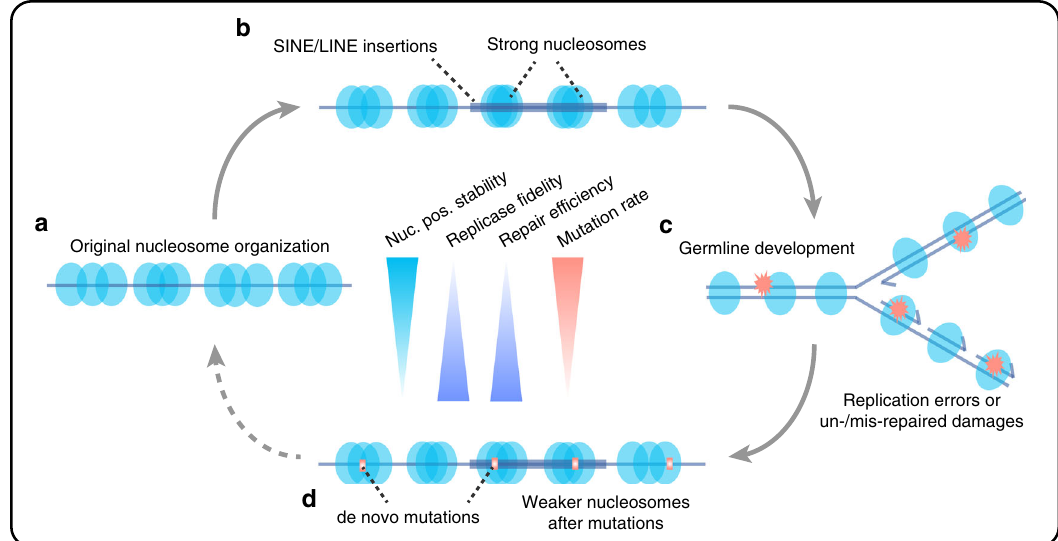
Fig. 6 Proposed model of the interplay between nucleosome translational stability, mutation rate, and transposable elements. a Most genomic regions are occupied by nucleosomes lacking strong translational stability. b Strong nucleosomes are preferentially associated with newly inserted SINE/LINE elements. c Strong nucleosomal regions are subject to high mutation rates during germline development, caused by mutational processes such as low replicase fi delity, inef fi cient MMR, and DSB repair. d Accumulation of mutations reduces translational stability of strong nucleosomes and reduces transposition capacity of transposable